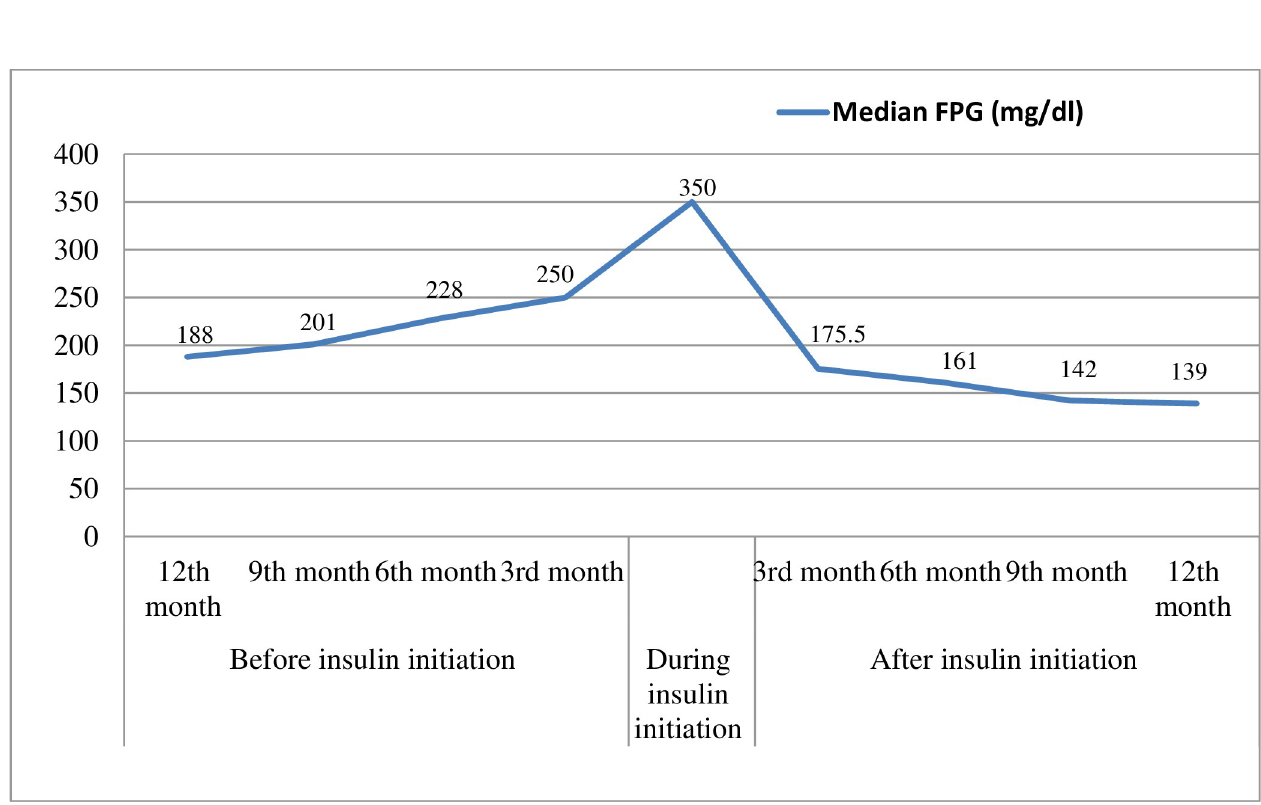
Fig 2. Trend of fasting blood glucose levels of participants during the 2-years of follow-up periods.